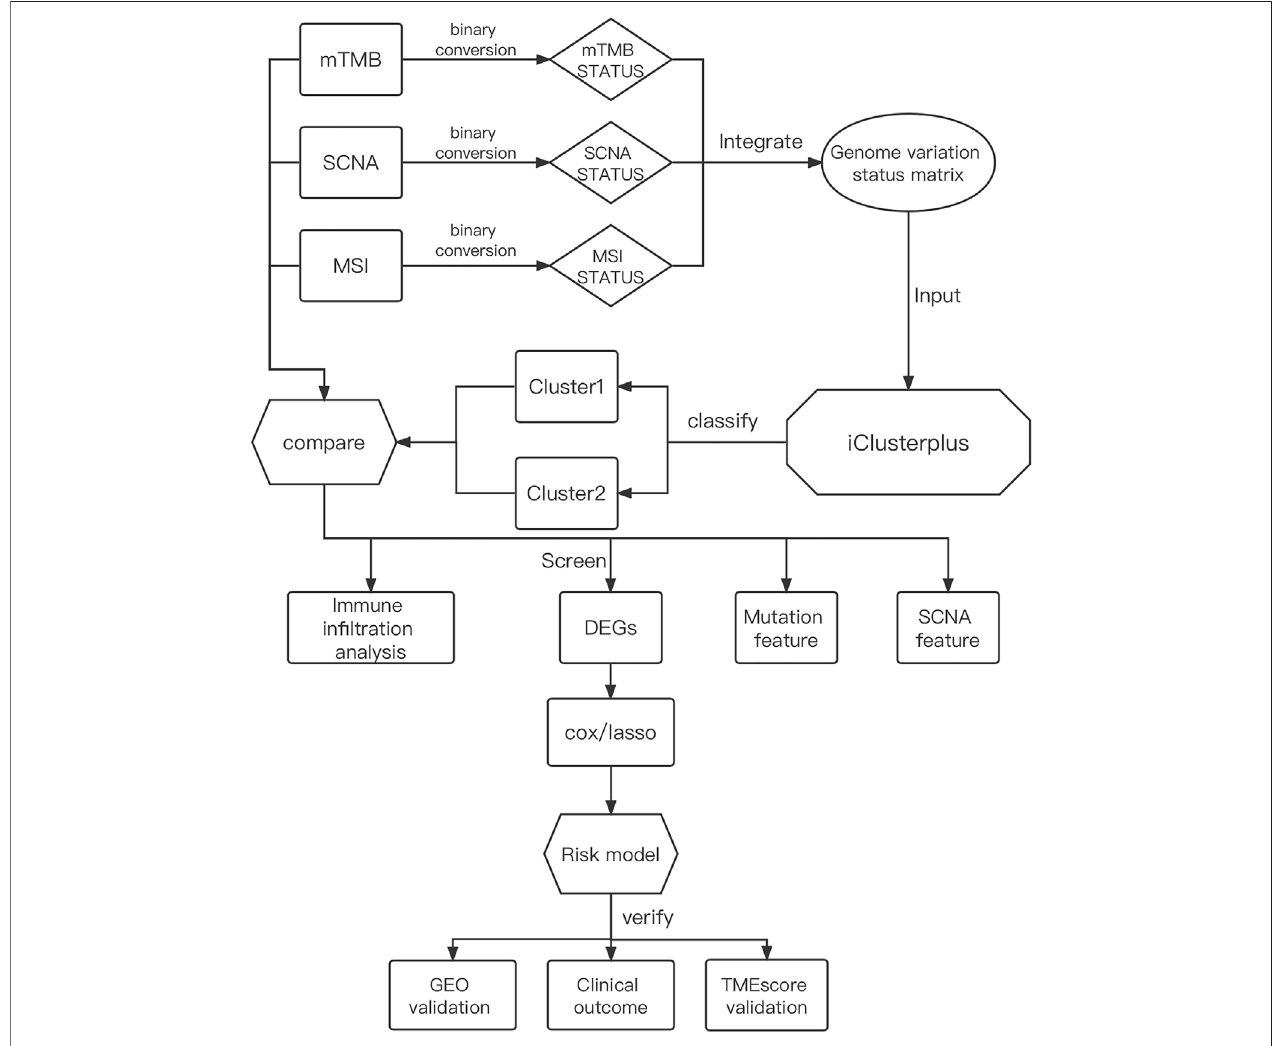
FIGURE 1 | Comprehensive work fl ow of our study for constructing the risk model in GC, including downloading and processing and analysis.